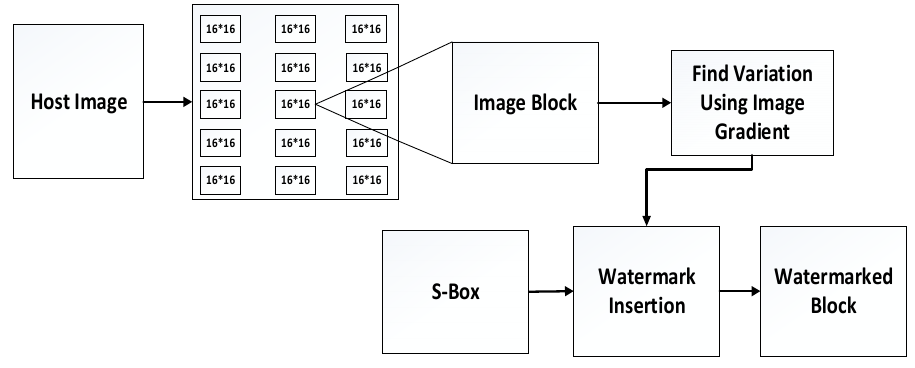
Figure 3. Watermark insertion flow diagram.